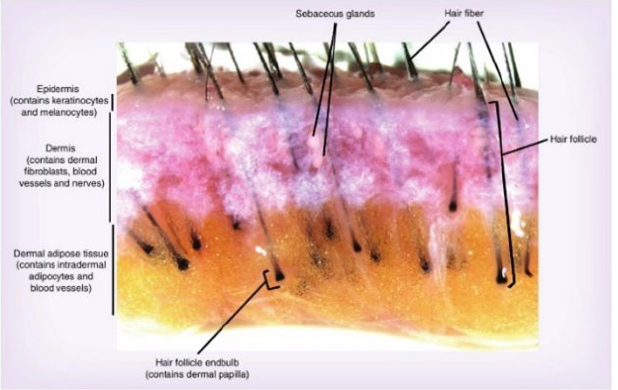
Figure 8. Cross-section of scalp tissue .